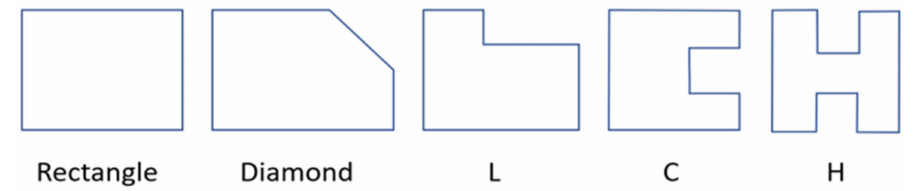
Figure 2. Sketch of five studied